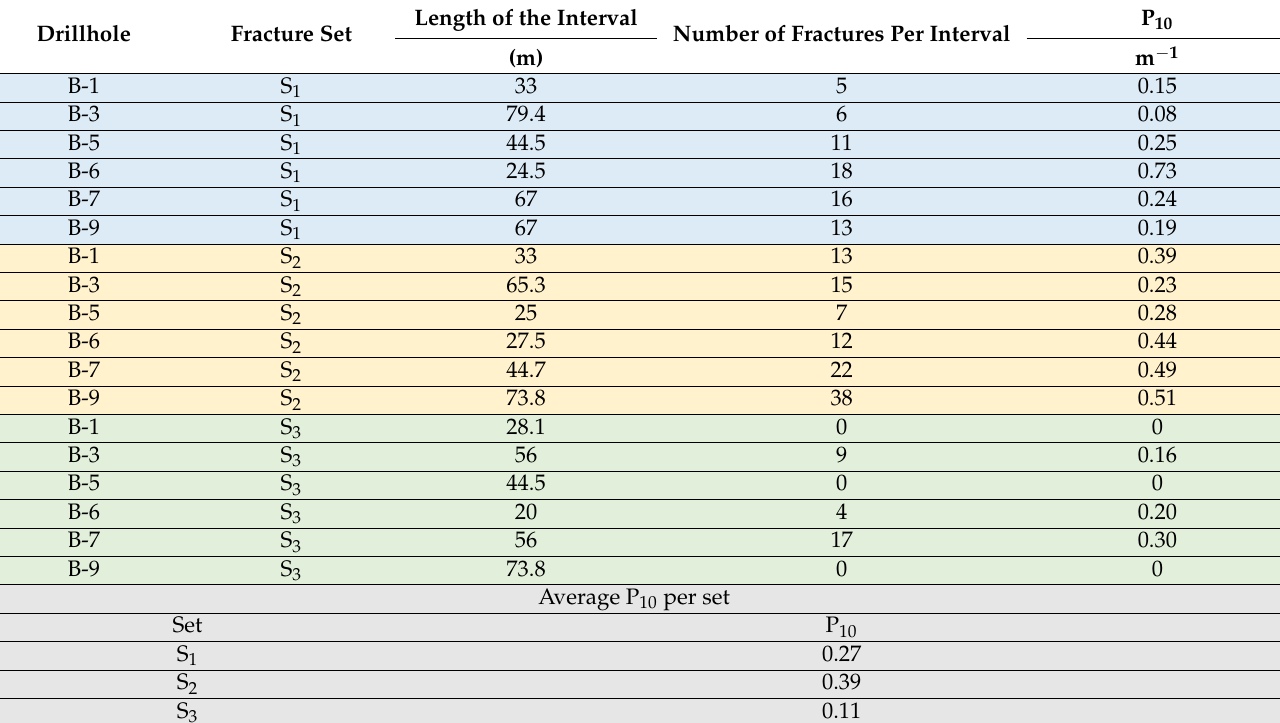
Table 2. Linear density/intensity of fractures—P 10